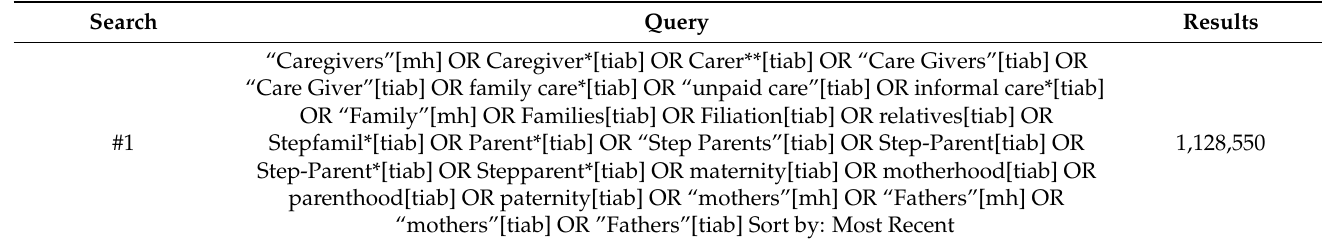
Table 2. Search strategy conducted on the PubMed